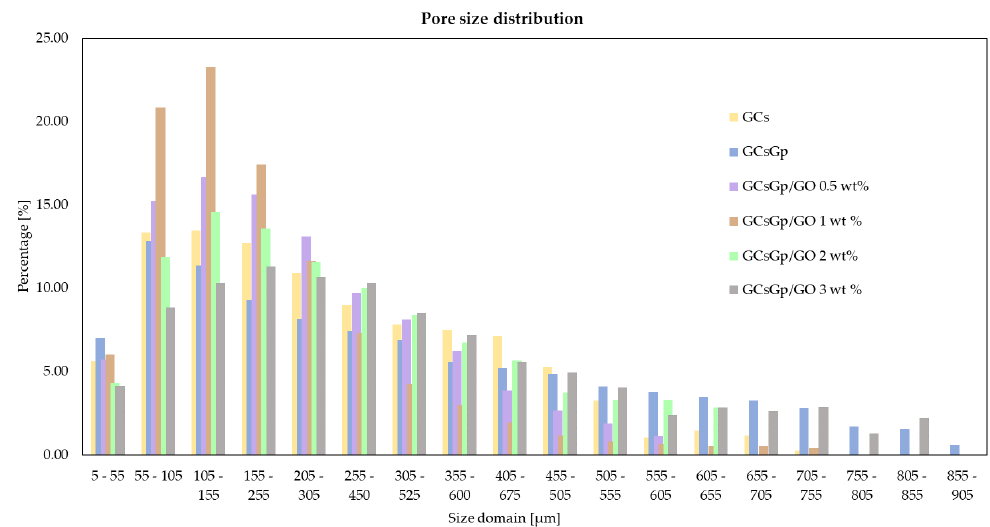
Figure 4. Rendering of the averaged pore size in GCs, GCsGp, GCsGp / GO 0.5%, GCsGp / GO 1%, GCsGp / GO 2%, and GCsGp / GO 3% specimens measured in CTAn software from the 3D tomograms.